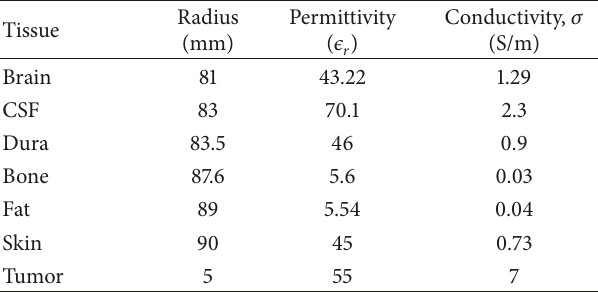
Table 2: Dielectric properties of the spherical cancerous head phantom with approximate